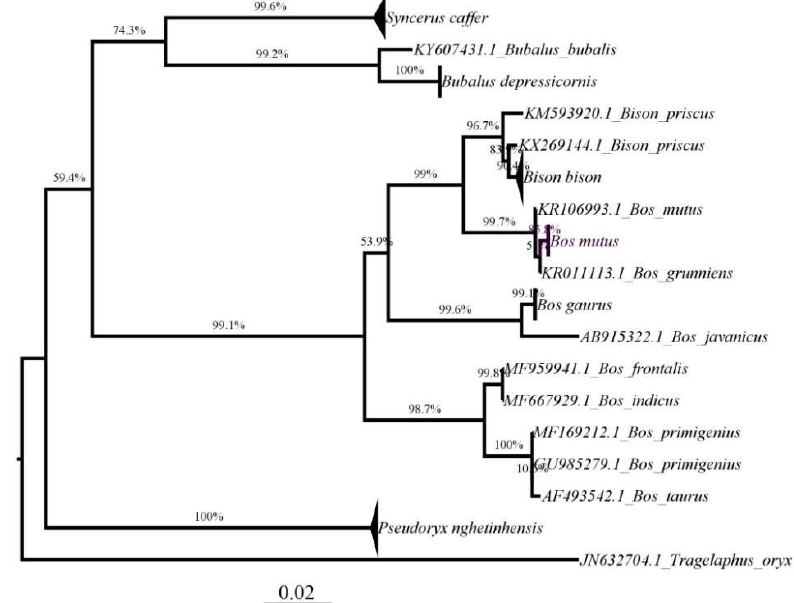
Fig. 2. Maximum Likelihood tree based on the Hasegawa-Kishino-Yano (HKY+G) distance using NADH dehydrogenase subunit I ( ND1 ) sequences; the numbers on each branch correspond to the bootstrap support values. The tree was rooted with T. oryx ; [{ Syncerus caffer + ( Bubalus bubalis + Bu. depressicornis )}+ {{(( Bi. priscus + Bi. bison )+ ( B. mutus + ( B. mutus + B.